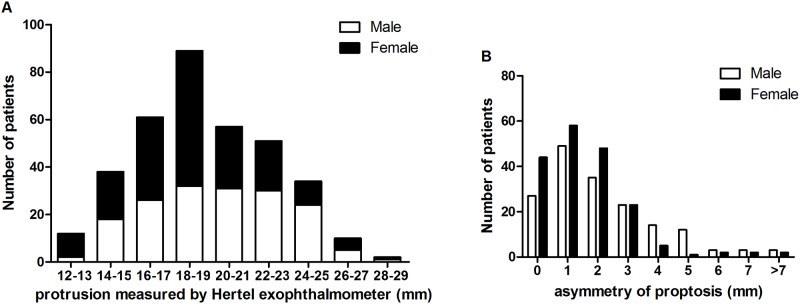
Distribution of exophthalmometric value (worst eye) (A) and asymmetry of proptosis (B) for the patients with moderate-to-severe TAO.